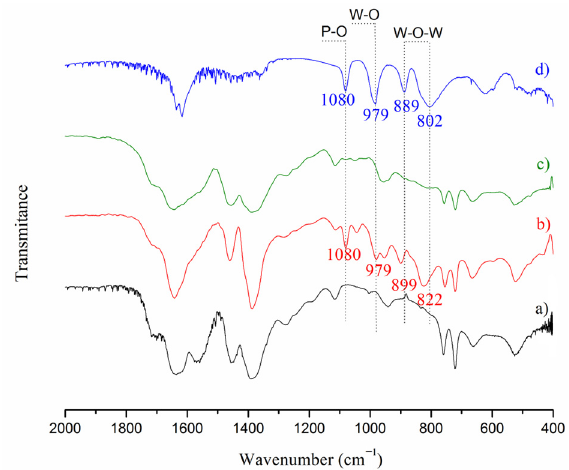
Figure 2. FTIR spectra of MIL-100(Cr) ( a ), PW12@MIL-100(Cr) ( b ), PW4@MIL-100(Cr) ( c ) and PTA ( d ).